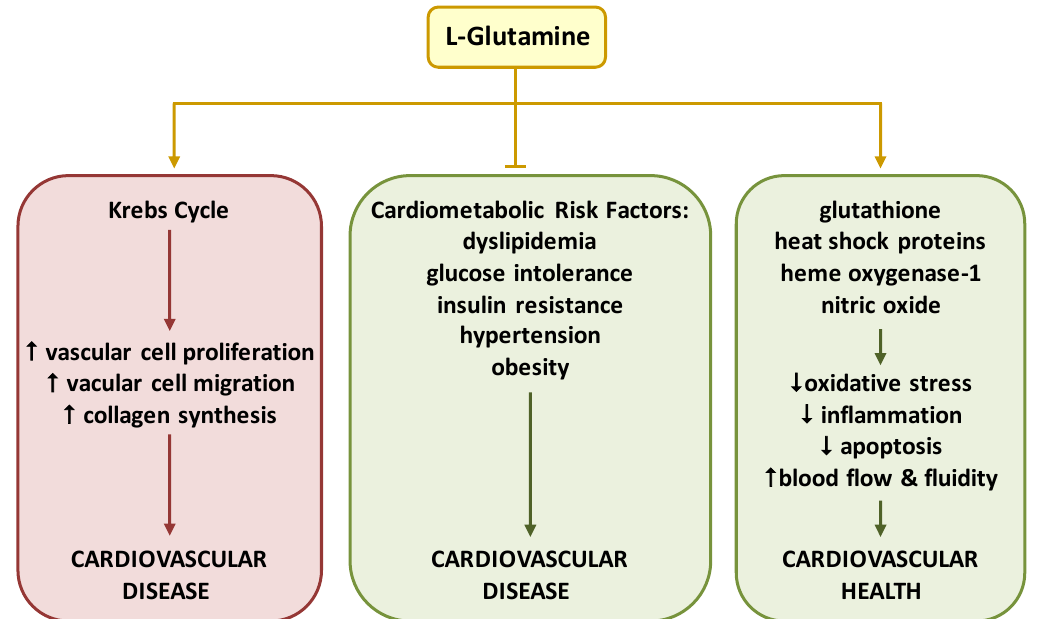
Figure 3. Emerging role of L -glutamine (Gln) in cardiovascular health and disease. Multiple mechanisms mediate the beneficial actions of Gln. In particular, Gln exerts potent antioxidant, anti-inflammatory, and anti-apoptotic effects in the circulation by stimulating the expression of glutathione, heat shock proteins, and heme oxygenase-1. In addition, L -glutamine stimulates blood flow and fluidity by generating nitric oxide. Moreover, Gln alleviates many known risk factors for cardiovascular disease, including dyslipidemia, glucose intolerance, insulin resistance, hypertension, and obesity. However, in some instances, excessive shunting of L -glutamine into the Krebs cycle can promote cardiovascular disease by stimulating aberrant vascular cell proliferation, migration, and collagen synthesis.